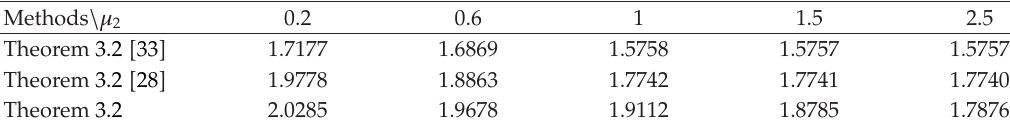
(cid:8) 0 . 8 in Example 2 , and δ 0